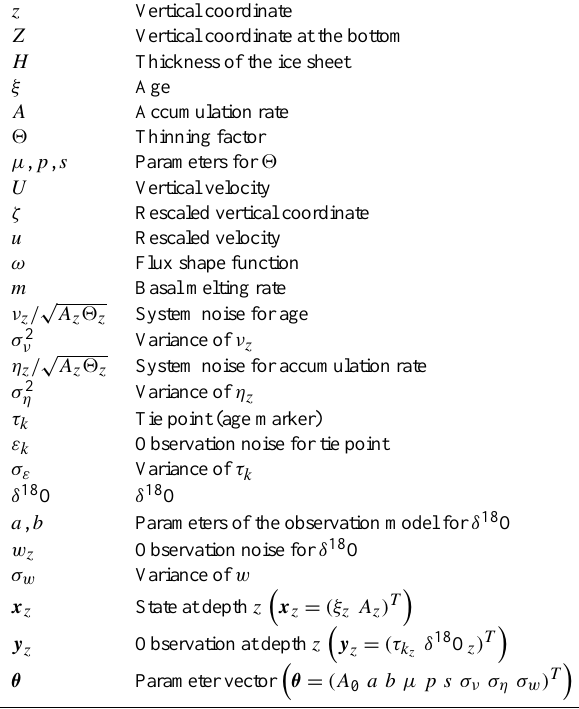
Table A1. Definition of the variables used in this